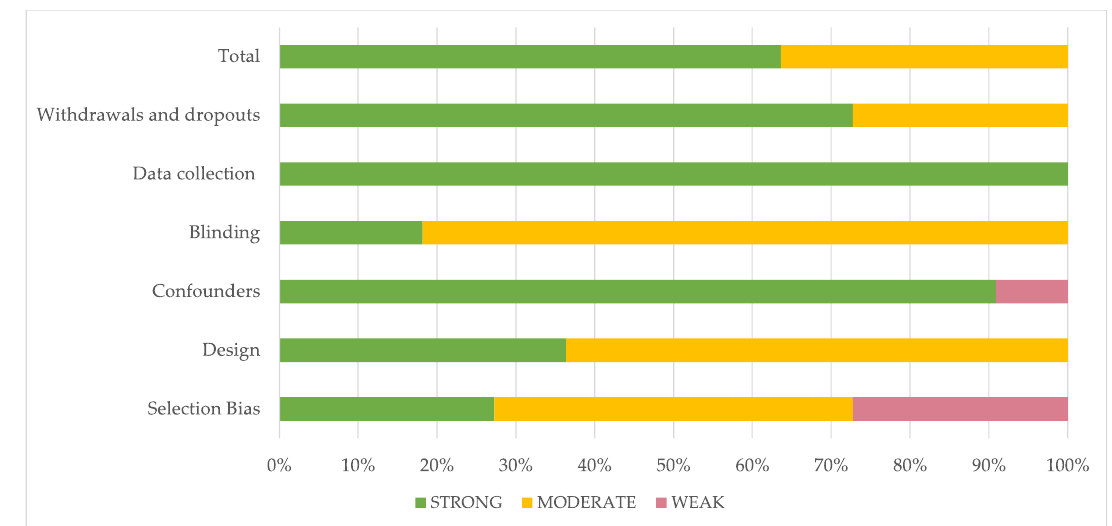
Figure 2. Evaluation of the individual items within the quality sections presented as percentages across all included Scheme.